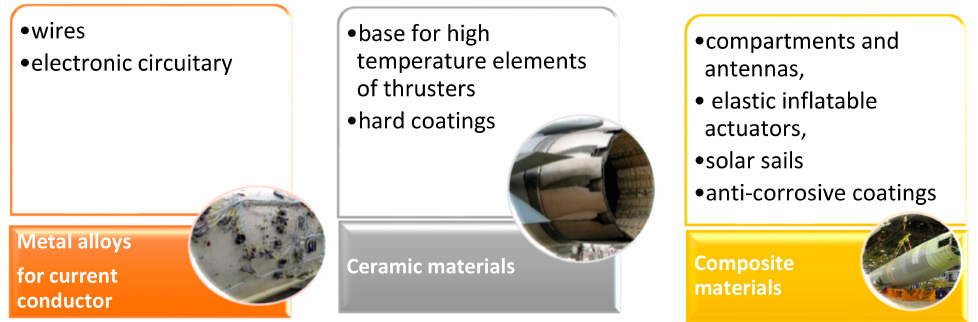
Figure 9. Classification of self-healing materials in spacecraft